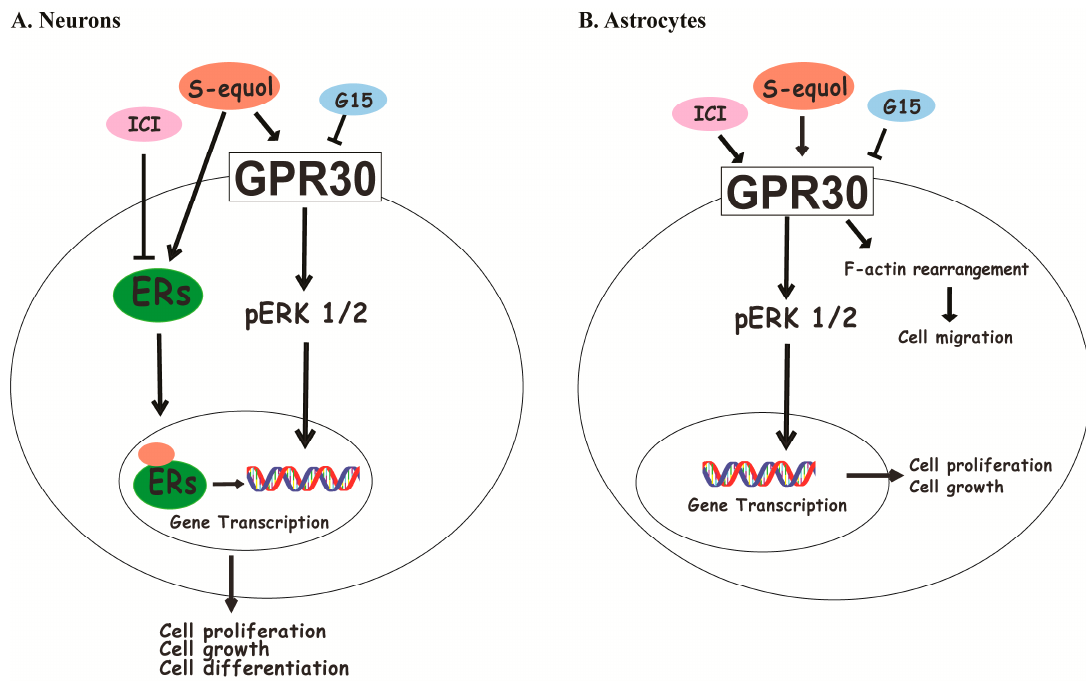
Figure 5. The proposed mechanism of S-equol in cerebellar development through both genomic and nongenomic actions. S-equol enters the cells and may bind ( ↓ ) to the cytoplasmic, nuclear ERs or GPR30 to induce gene transcription, which leads to cell growth and augmentation of dendrite arborization in neurons ( A ). These effects were suppressed by an ER inhibitor, (i.e., ICI ┴ ( )). On the other hand, S-equol also activated the GPR30 ↓ ( ) signaling pathway through the activation of phosphorylation of ERK1/2, enhanced cell proliferation, and induced F-actin rearrangement to increase cell migration in astrocytes ( B ). These effects were suppressed by the GPR30 inhibitor G15 ┴ ( ).